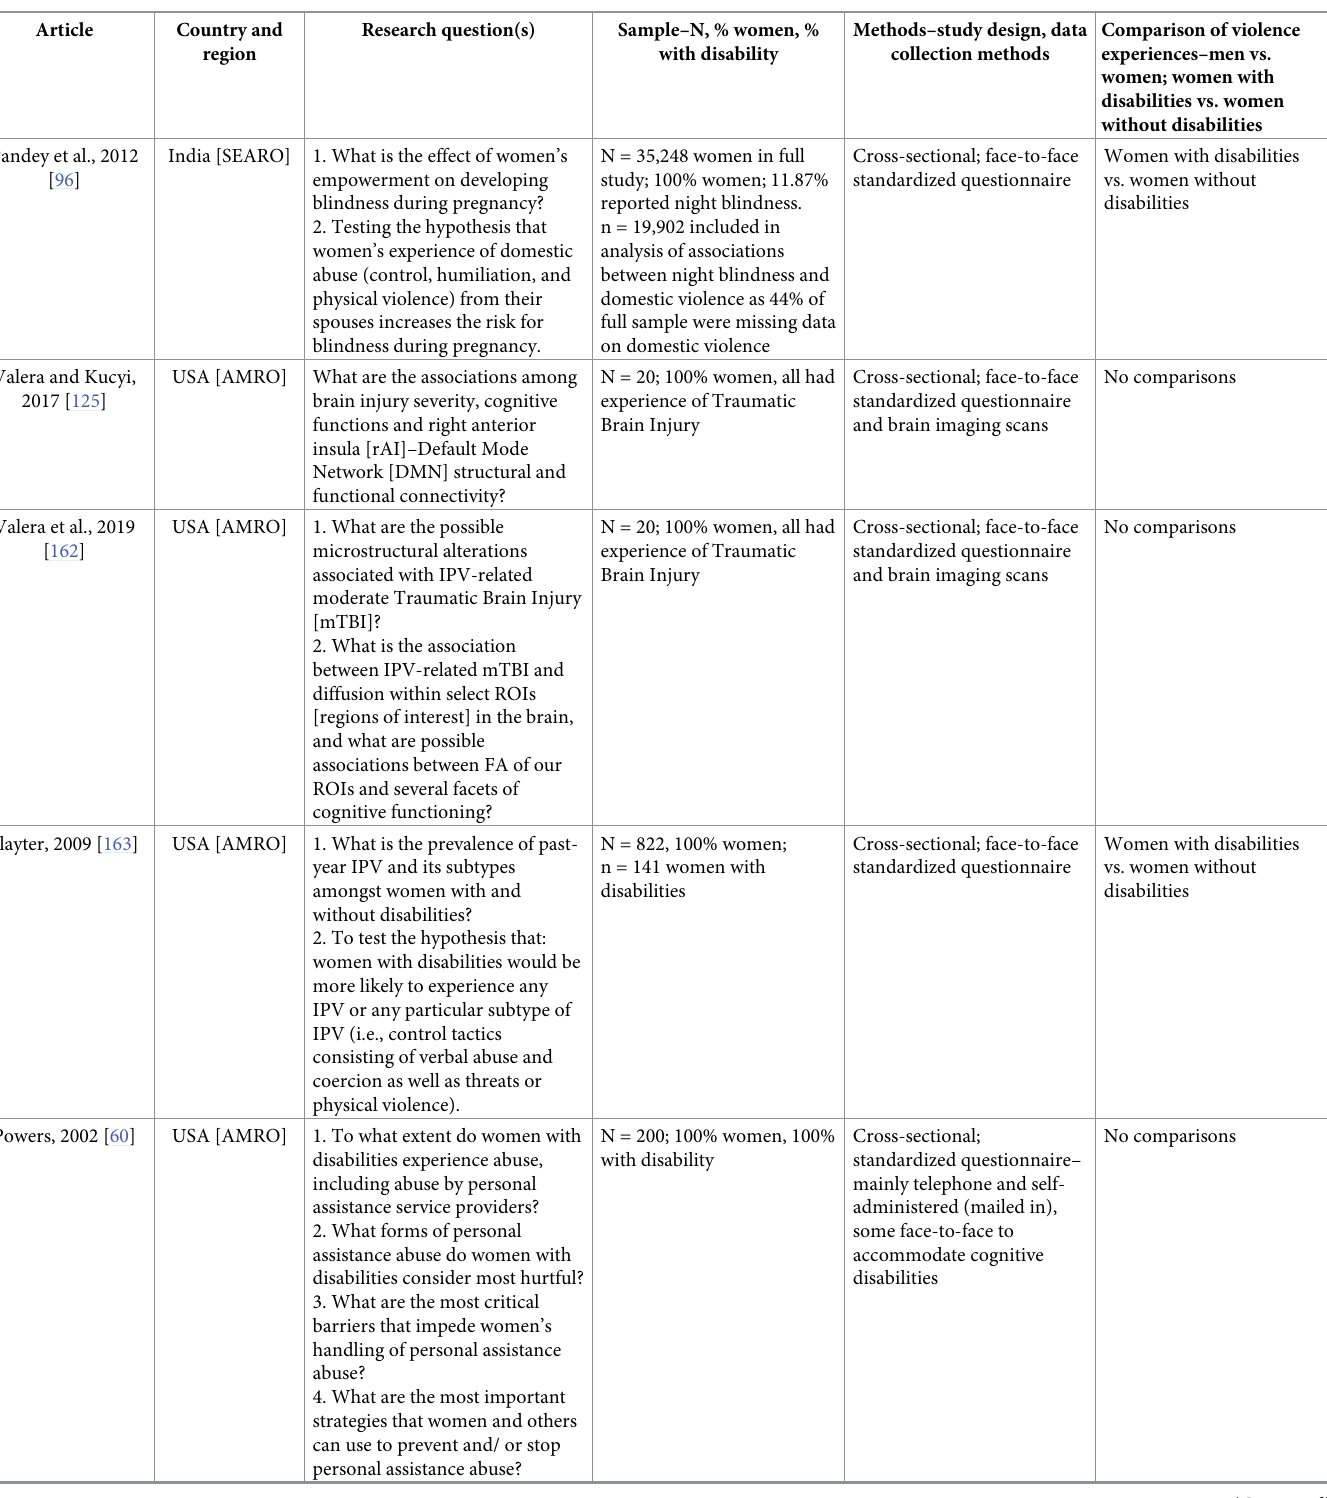
Table 2. Characteristics of included